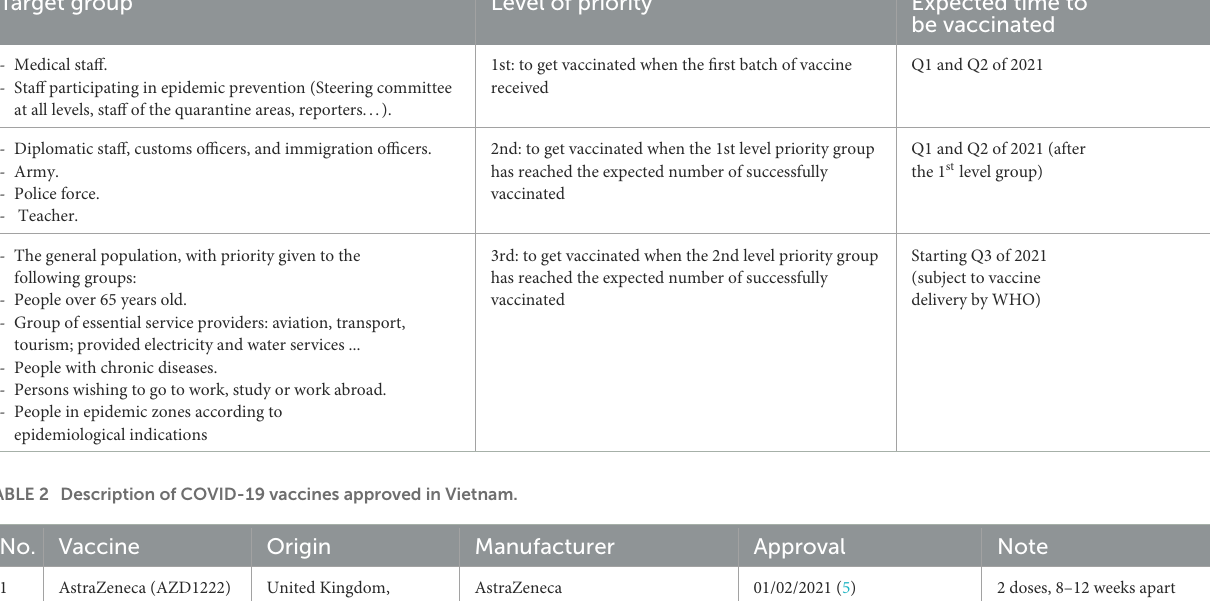
TABLE 1 Vaccination target groups according to the schedule of vaccine supply. Target group Level of priority Expected time to